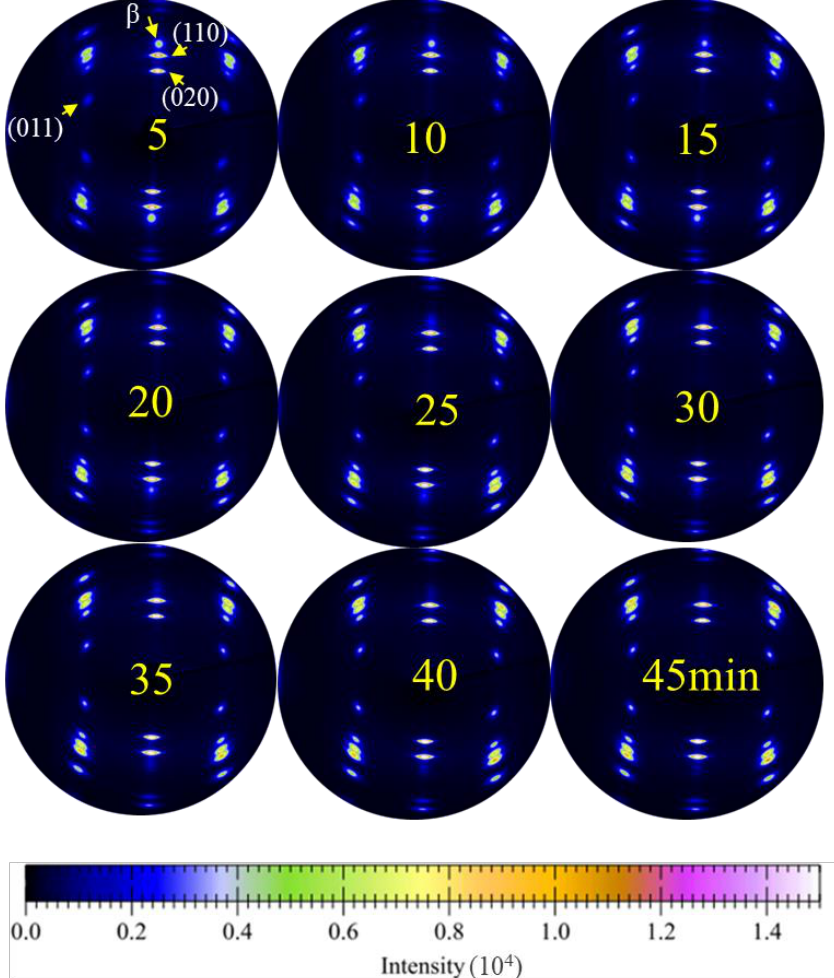
Figure 2. Real-time 2D-WAXD patterns of the two-step-drawn PHBV films obtained during annealing at 130 ◦ C at different times, as labeled on the patterns. The drawing direction is horizontal and is defined as the meridian in this paper.